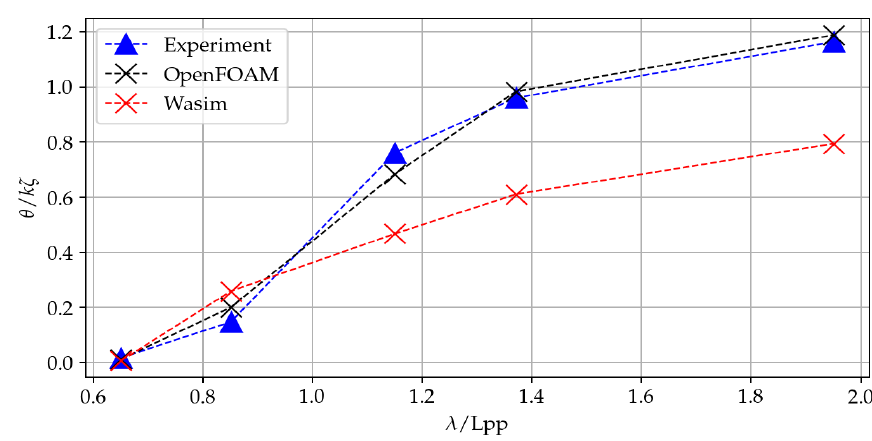
Figure 27. Transfer functions of heave motion for the KRISO containership.